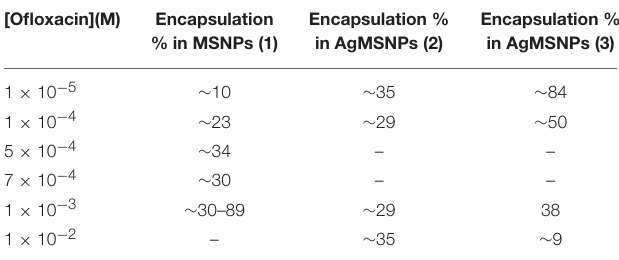
TABLE 4 | Encapsulation % of ofloxacin in MSNPs and AgMSNPs in DMSO (1), (2), and PBS pH 7.4 (3). [Ofloxacin](M)